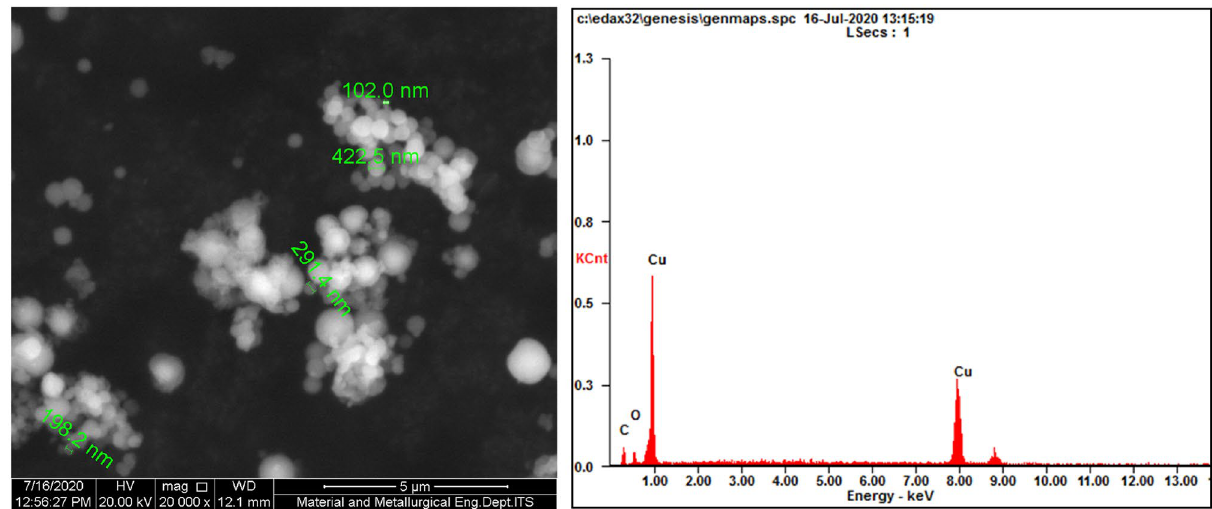
Figure 1. A SEM image of the CuNPs and an EDX spectrum of the spot particles. Left picture: the average size of the particles measured was 254 nm, ranging from 102 to 423 nm in the SEM image. Right graph: the percentage of Cu 2 O element composition on spot particles counted using